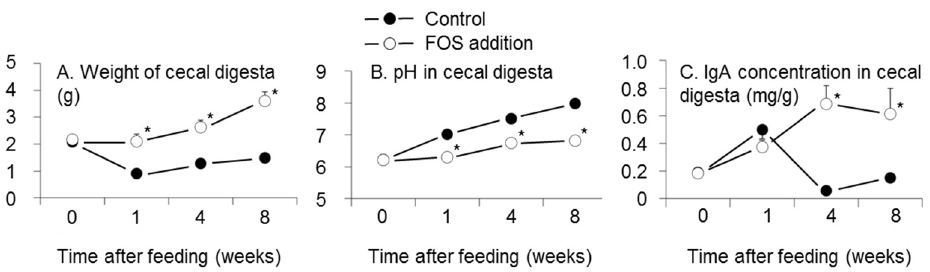
Figure 2. Effects of fructooligosaccharides (FOS) addition and duration of feeding for test diets on the weight of cecal digesta ( A ); pH in cecal digesta ( B ); and IgA concentration in cecal digesta ( C ). n = 6 per group at each time. Symbols and vertical bars represent means and standard errors, respectively. There were interactions between FOS addition and intake period in the weight of cecal contents, pH in cecal digesta, and IgA concentration in cecal digesta ( p = 0.0002, p < 0.0001, and p < 0.0001, respectively, two way ANOVA). * p < 0.05 versus control group at each week using Tukey’s multiple comparison.